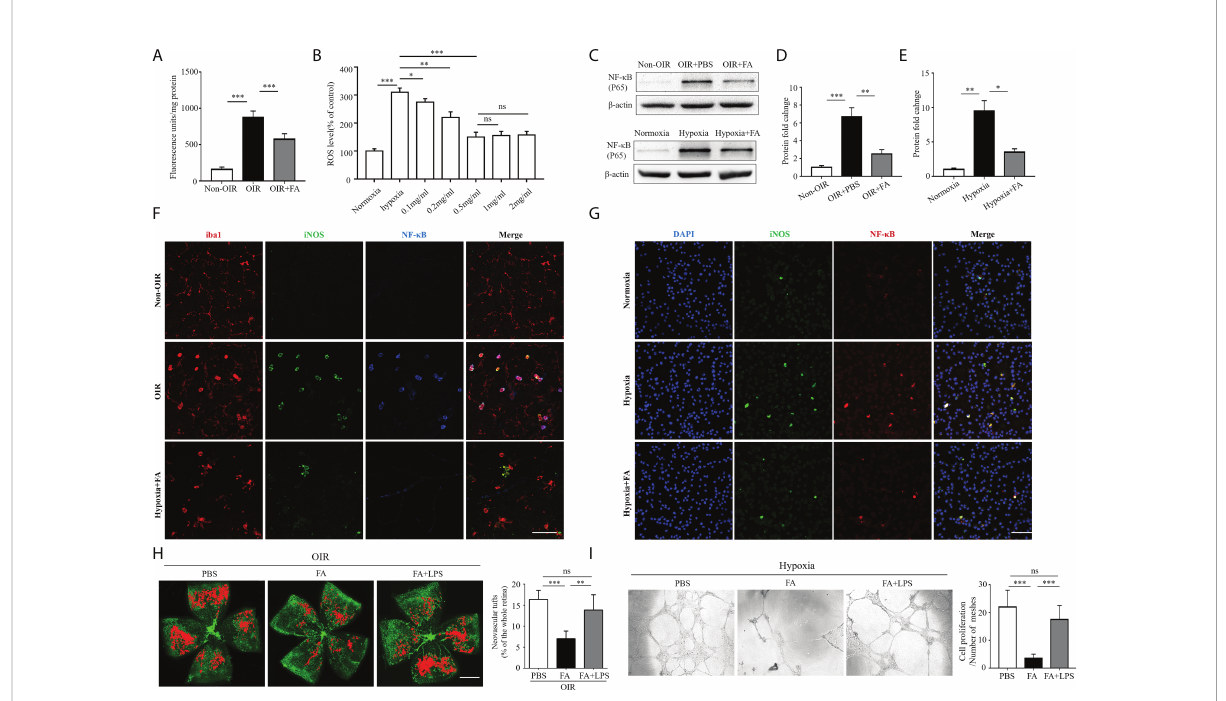
FIGURE 6 FA exerted anti-angiogenic activities via inhibiting the ROS/NF- k B signaling. (A) Measurement of ROS levels in the retina under in vivo conditions. Retina from OIR and control mice was incubated at 37°C in vials with 5 µM DCFH-DA as described in the method section. The extent of the oxidized fl uorescence was measured in each excised retina and presented as fl uorescence units/mg of retinal protein. n = 6 mice in each group. (B) DCFH-DA was used to detect ROS levels in cultured BV2 cell lines in hypoxic conditions. The results were expressed as percentage of change in fl uorescence and the control group was taken as 100%. For treatment, FA was added to the culture medium with different concentrations. (C – E) Western blot showed that protein levels of NF- k B (p65) was up-regulated in both OIR retina (C, D) and hypoxia- stimulated BV2 cells (C, E) , which could be signi fi cantly reversed with FA administration. (F, G) Immunostaining on retinal wholemounts (F) and cultured BV2 cells (G) showing co-labeling of iNOS and NF- k B in iba1 + cells under hypoxic condition. Note that FA treatment signi fi cantly decreased the number of iNOS + NF- k B + cells. Scale bar, 100 m m. n = 6 mice. (H) Isolectin-B4 staining on retinal whole-mounts showed that the combination of LPS treatment abolished the anti-neovascular effect of FA in the OIR retina. Scale bar, 1 mm. n= 10 mice. (I) Human retinal endothelial cells (HRECs) tube formation assay revealed that co-treatment of LPS with FA signi fi cantly reversed the effect of single FA treatment on inhibition of HRECs tube formation. Data are presented as mean ± SEM. * P < 0.05, ** P < 0.01, *** P < 0.001, ns, no signi fi